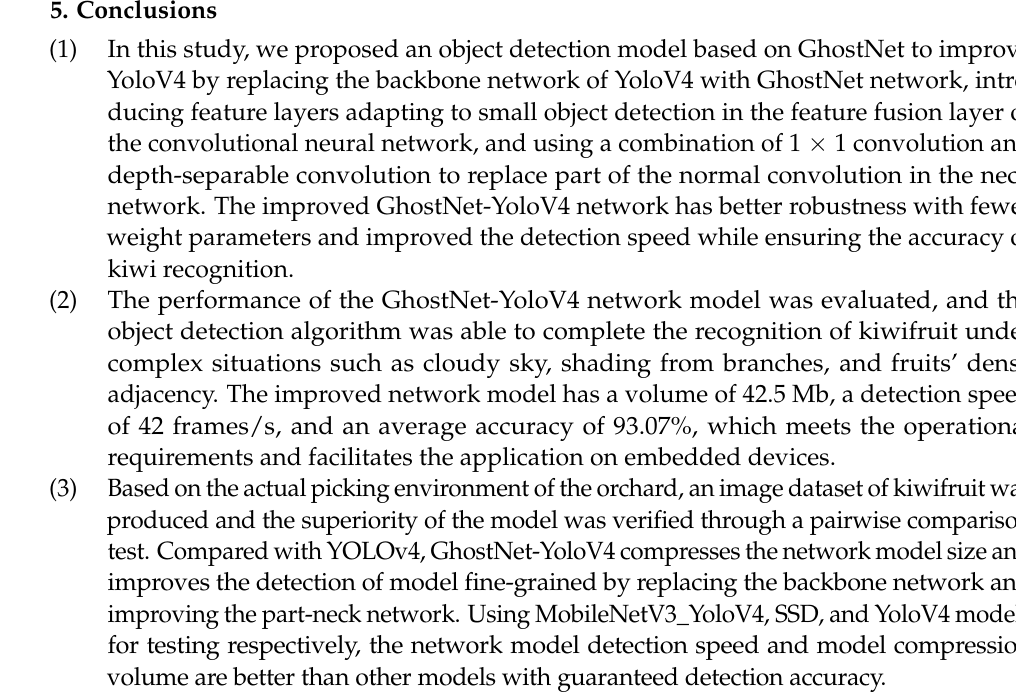
Figure 11. Comparison of recognition results using different models.